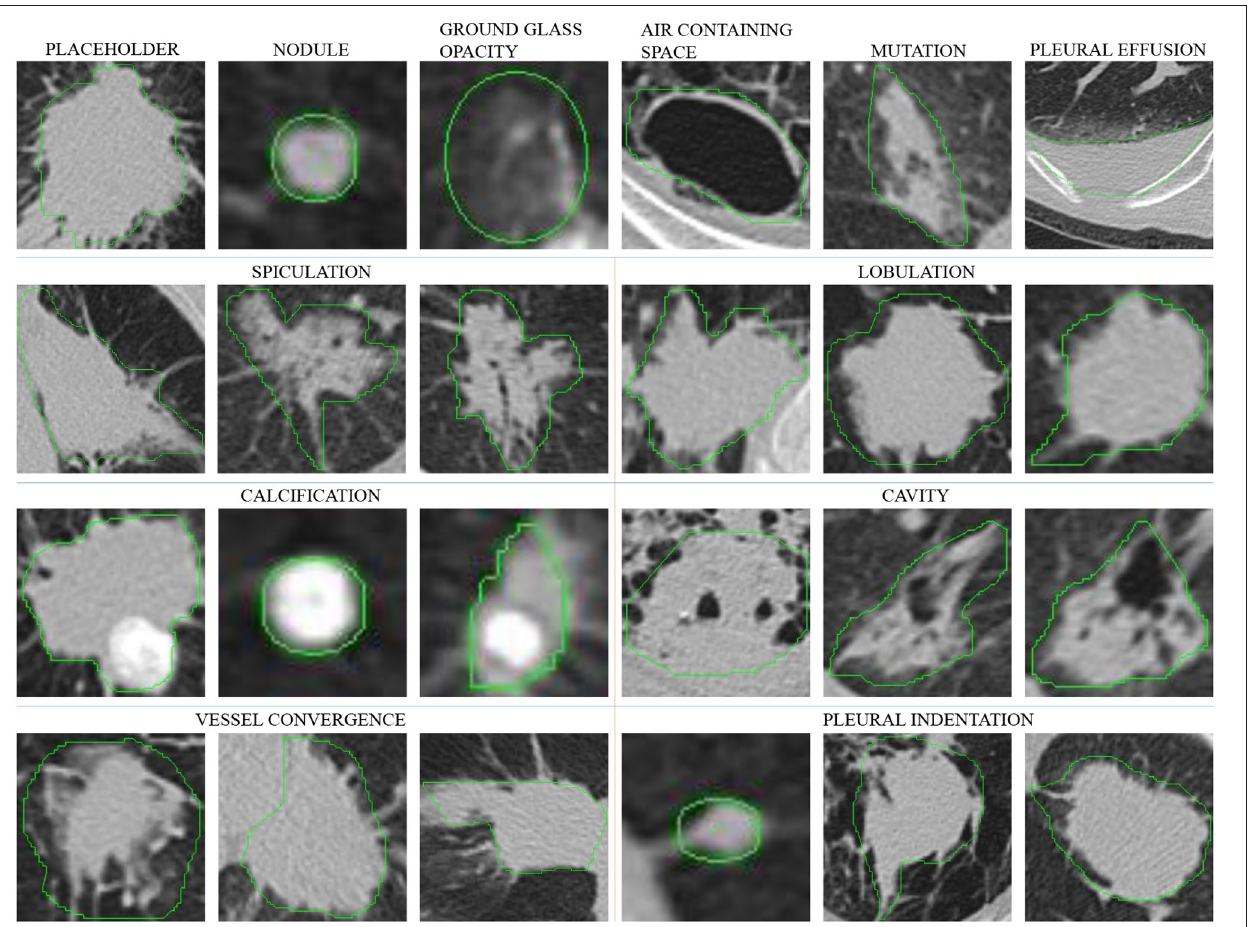
FIGURE 1 | Lesions in our dataset. Except for some small nodules, which are marked with a circle, such as the second image in the first row, other lesions are marked by a very close contour. The six images in the first row are different types of lesions, and in the second to fourth rows, each set of three images are spiculation, lobulation, calcification, cavity, vessel convergence, and pleural